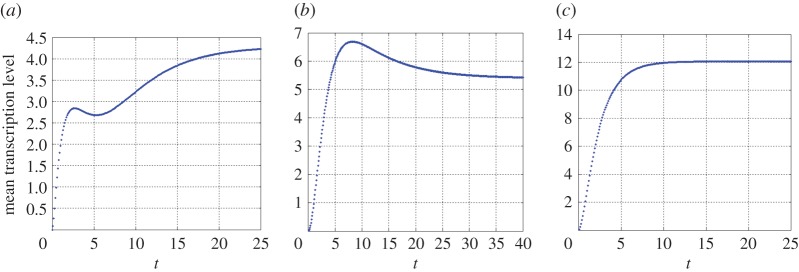
Multiple growth patterns of transcription dynamics activated by two promoter states. The three curves are generated by (3.6) and (3.7) with q1 = 0.4, q2 = 0.6, ν1 = ν2 = 15 min−1 and δ = 0.5 min−1. (a) λ1 = 0.027, γ1 = 0.17, λ2 = 2.16 and γ2 = 3.68. (b) λ1 = 0.027, γ1 = 0.17, λ2 = 0.3, and γ2 = 0.45. (c) λ1 = 0.7, γ1 = 7.5, λ2 = 1.1 and γ2 = 0.86. All units in (a–c) are min−1.